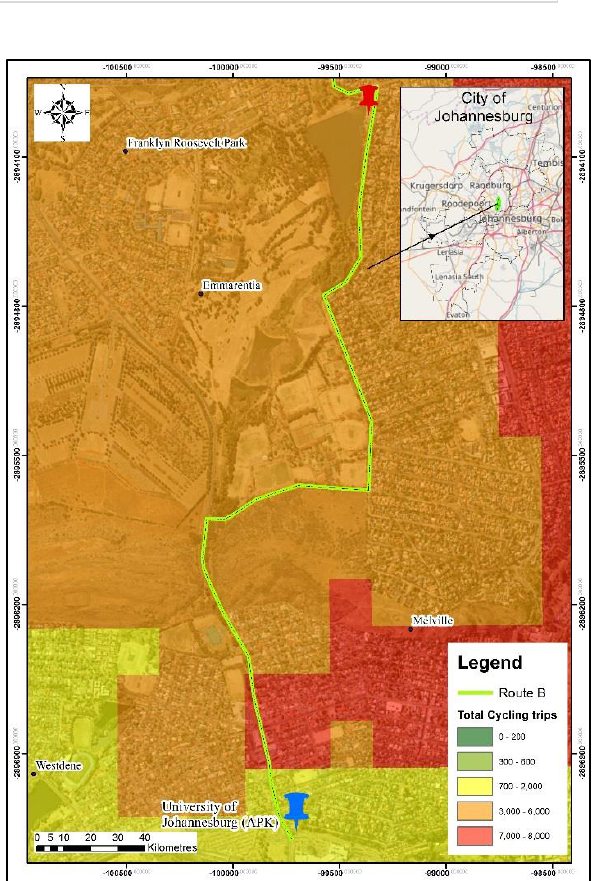
Figure 5: Route B overlaid with Total cycling trips recorded on Strava